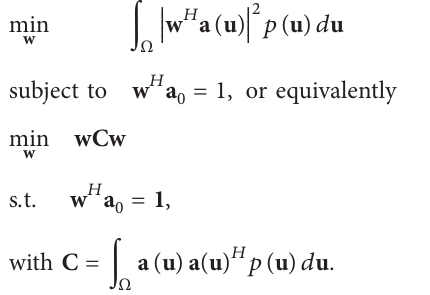
Figure 3: Low sidelobes by amplitude